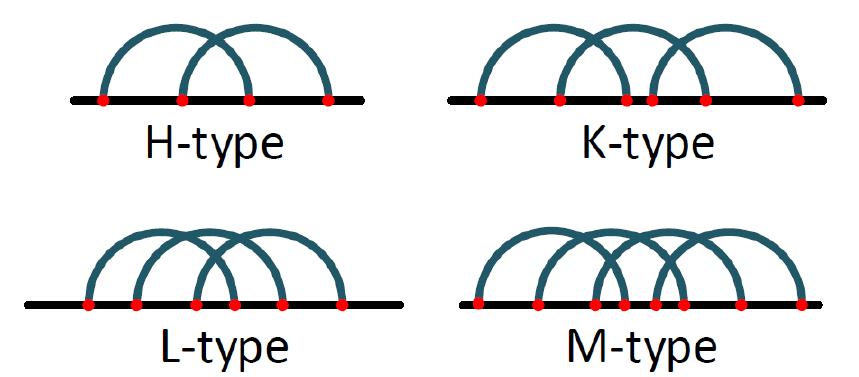
Figure 1. Four basic types of